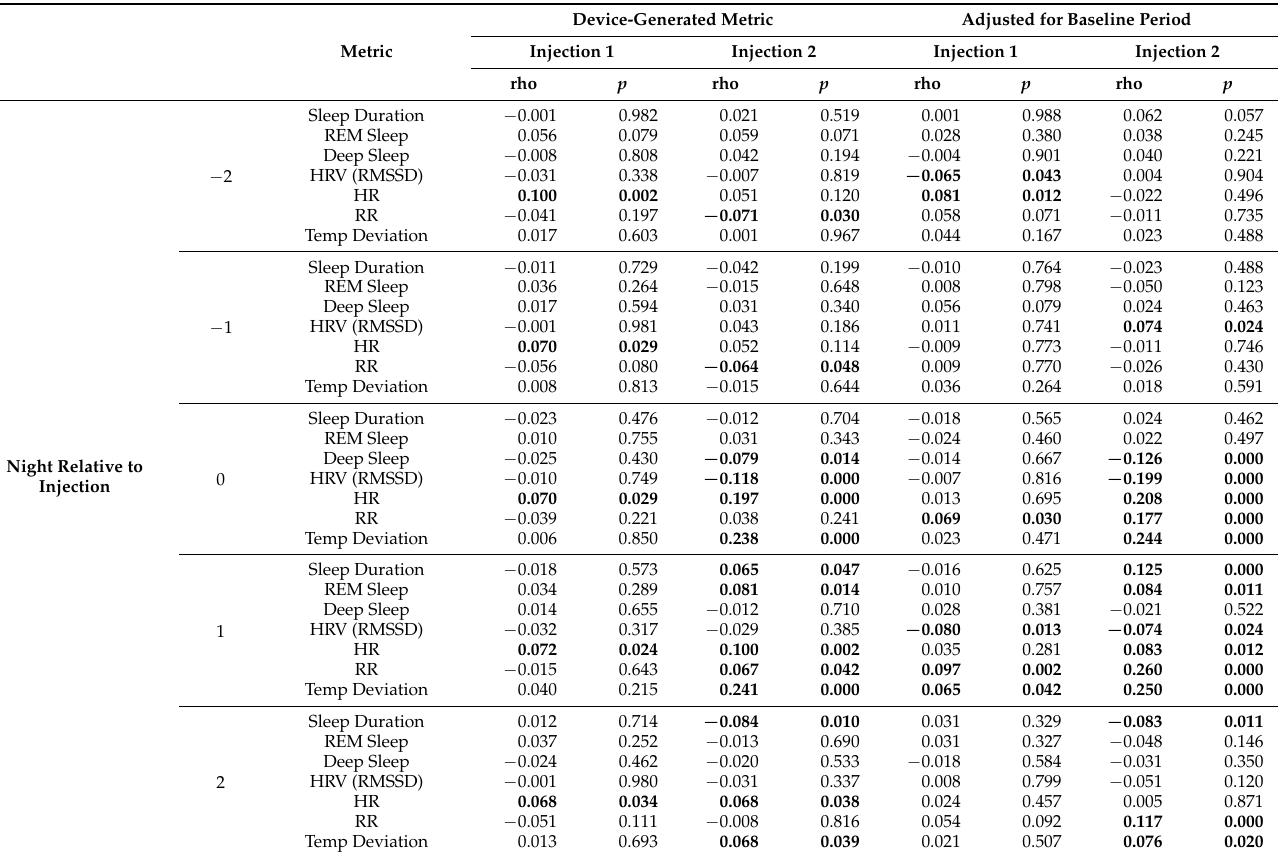
Table 3. Spearman rank order correlations between RBD antibody responses and device-generated metrics before and after adjusting for the pre-vaccination baseline period on nights before and after injections for Moderna-NIAID and Pfizer-BioNTech vaccine recipients, combined. Device-Generated Metric Adjusted for Baseline Period Metric Injection 1 Injection 2 Injection 1 Injection 2